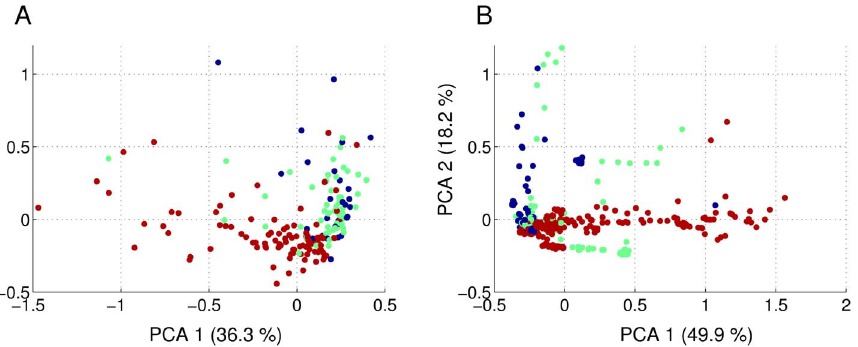
Figure 4. Principal component analysis in the 16 dimensional feature space. The plots display the first two principal components of all considered recordings in data set 1 (A) and data set 2 (B). Each point represents one recording and is colour coded as a good (red), intermediate (green) or bad (blue) recording, according to evaluation by researcher 1. We note that there is a systematic structure to the clouds of points representing the three recording qualities but the clusters are not fully separated.